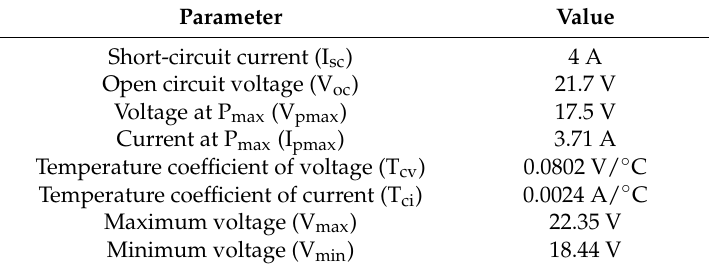
Table 1. Electrical parameters of the photovoltaic (PV) module type YL65P-17b. Parameter